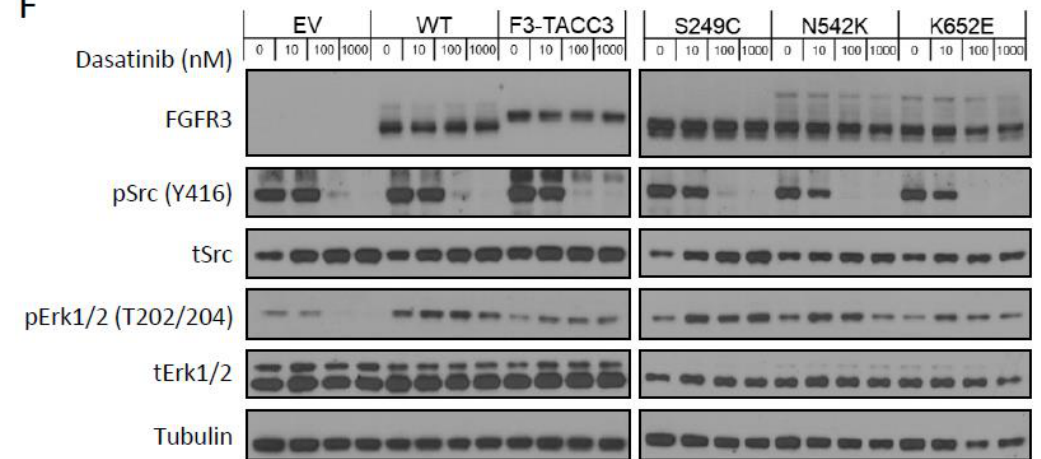
Figure 2. Cells expressing FGFR3-TACC3 and FGFR3 S249C mutant are resistant to dasatinib as a single agent. ( A ) Heatmap depicting one-way hierarchical clustering of cell viability data in the targeted drug screen. FGFR3 expressing NIH-3T3 cells were seeded in 96 well plates and viability measured using CTG assay following 72 h treatment with small molecule inhibitors at 500 nM (50 nM for NVP-AUY922). Cell viability data is normalised to DMSO control for each cell line and represented as a heatmap relative to WT FGFR3 cells ( n = 3). ( B ) Dose-response curves of the panel of NIH-3T3 cell lines upon treatment with dasatinib for 72 h. Cell viability is normalised to DMSO control treatment ( n = 3). ( C ) Bar plots showing IC 50 values of dasatinib calculated from dose response curves in ( B ). Statistical analysis of FGFR3 mutations and fusion versus WT FGFR3 was performed by one-way ANOVA with Dunnett’s post-hoc multiple comparison adjusted p -value (* p < 0.05). ( D ) Representative images of long term colony formation assay in the NIH-3T3 cell line panel upon treatment with dasatinib or DMSO control at the indicated doses for 2 weeks. ( E ) Bar plots showing the quantification of well coverage of the colony formation assay in panel D. Data for each cell line is normalised to DMSO control treatment ( n = 3). Statistical analysis of drug treatment versus DMSO was performed by two-way ANOVA with Dunnett’s post-hoc multiple comparison adjusted p -value (** p < 0.01, *** p < 0.001). ( F ) Immunoblot of Erk1 / 2 and Src phosphorylation levels in NIH-3T3 cells treated with dasatinib at the indicated doses for 6 h is shown. Data presented for ( B ), ( C ) and ( E ) represent mean ± SD. EV – empty vector control, WT – wildtype FGFR3, F3-TACC3 – FGFR3-TACC3.